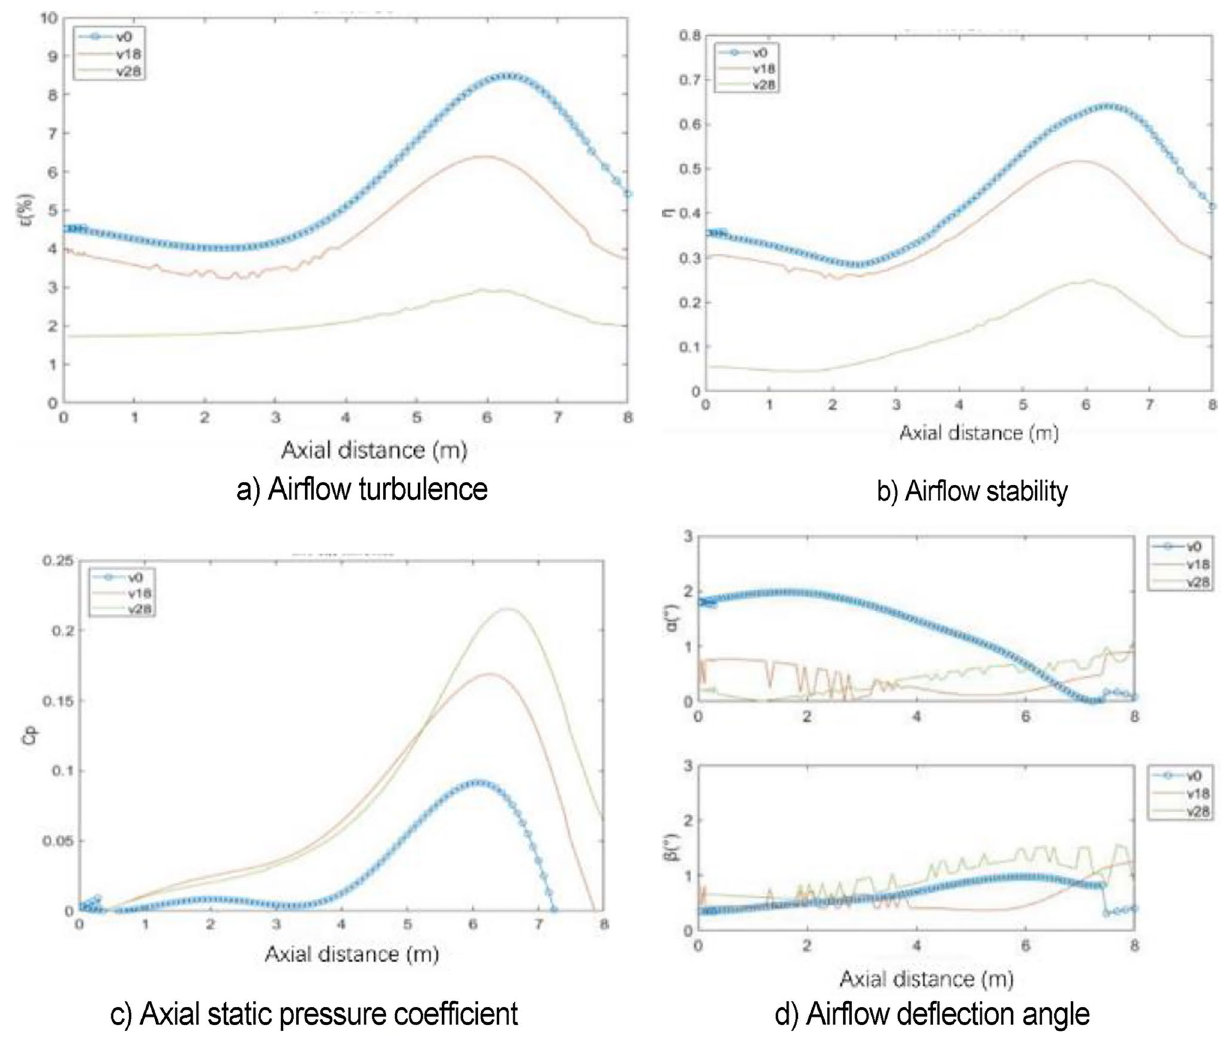
Figure 47. Flow field evaluation